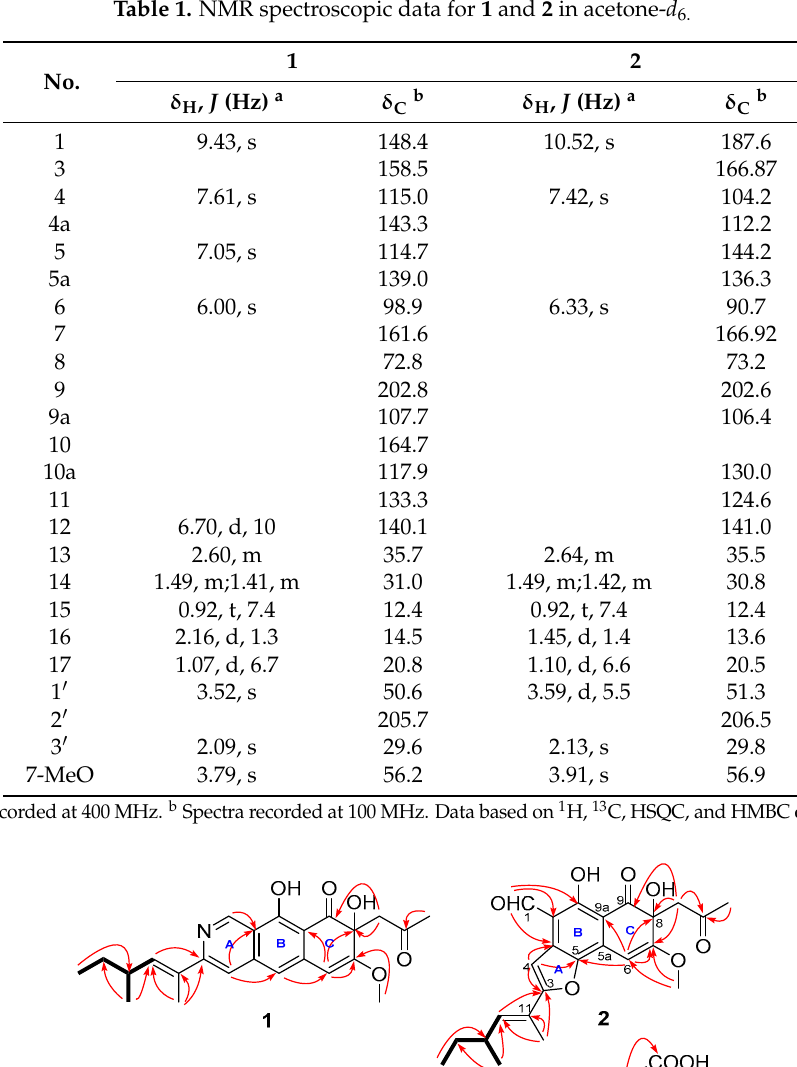
Table 1. NMR spectroscopic data for 1 and 2 in acetone- d 6.